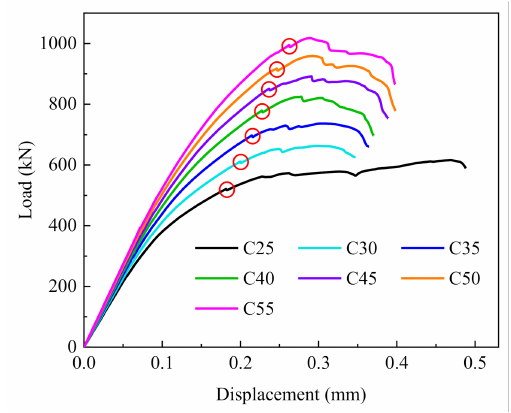
Figure 11. Load–displacement curves of S-SWJ with different concrete